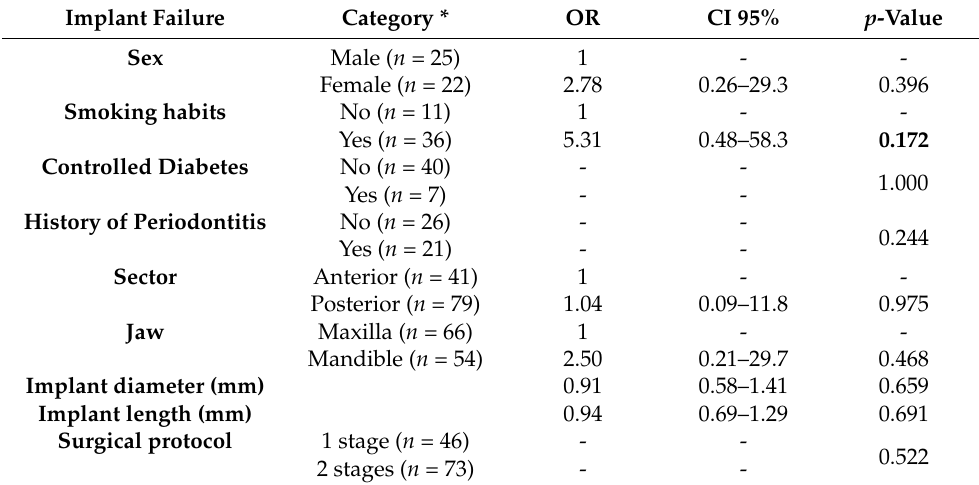
Table 4. Association between total MBL vs. independent covariates for patient profile, surgical pro- tocol, and implant characteristics. MBL vs. Independent Variables